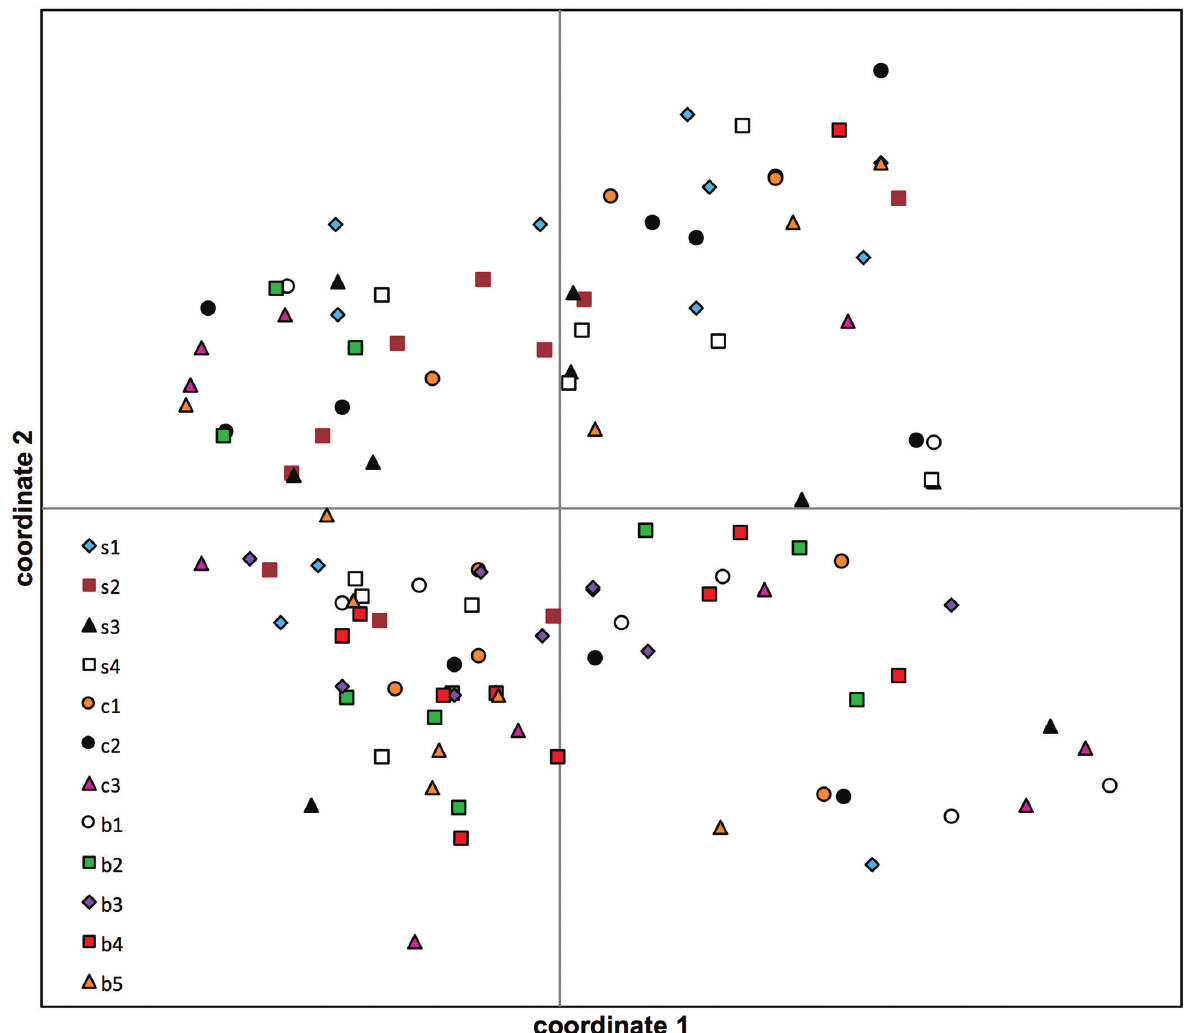
Figure 5. Principal coordinates analysis of ISSR genetic distances from the ‘small’ study showing overlap of populations. Popula- tions labeled as in Figure